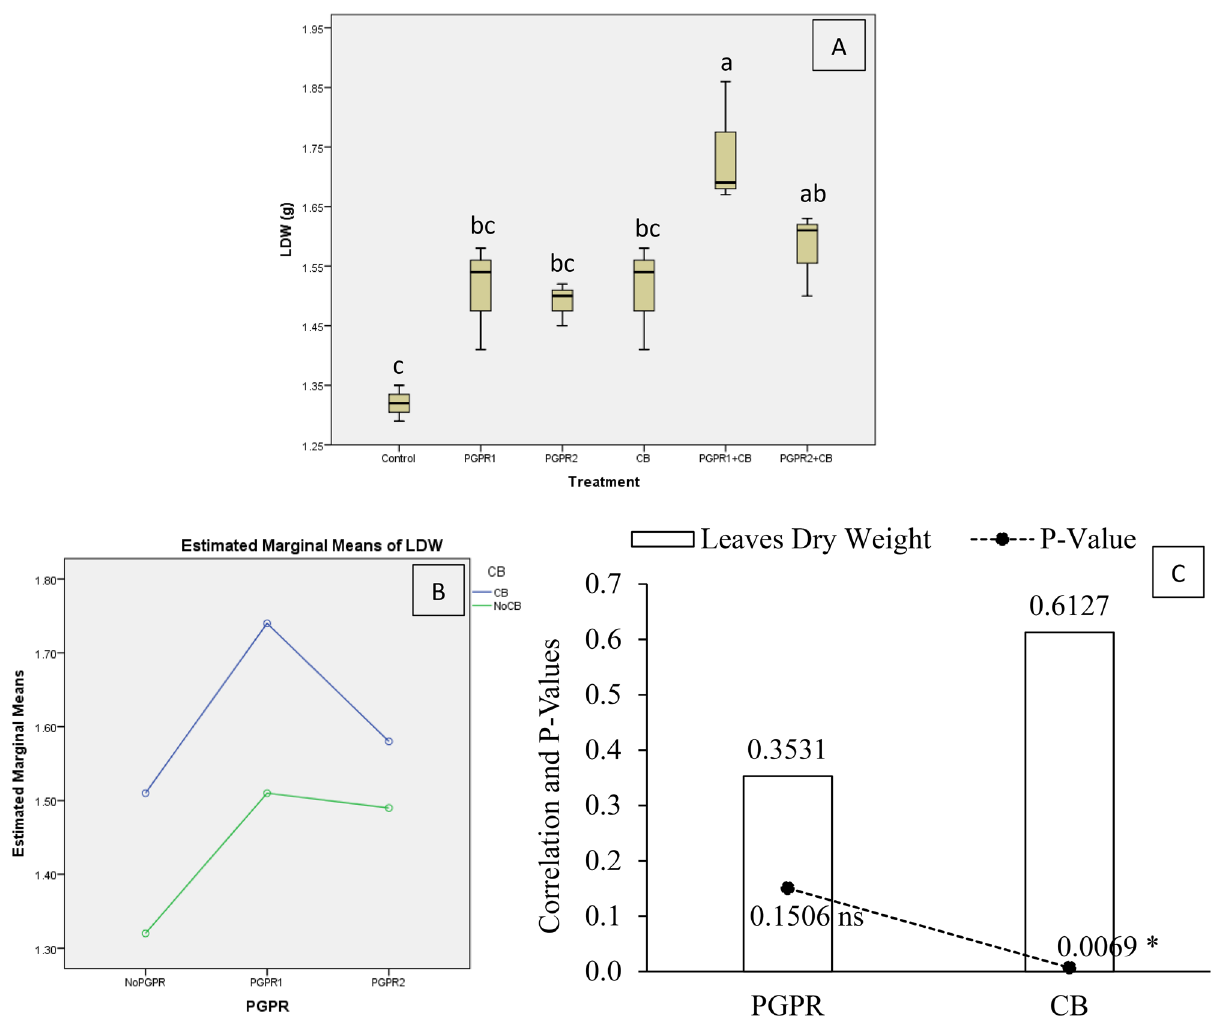
Figure 10. Effect of treatments on mint plants leaves dry weight (LDW). Values are the average of three replicates ( A ). Different letters showed significant differences (Tukey’s test; p ≤ 0.05). Interaction graph of PGPR and CB for LDW ( B ). Correlation graph of PGPR and CB for LDW ( C